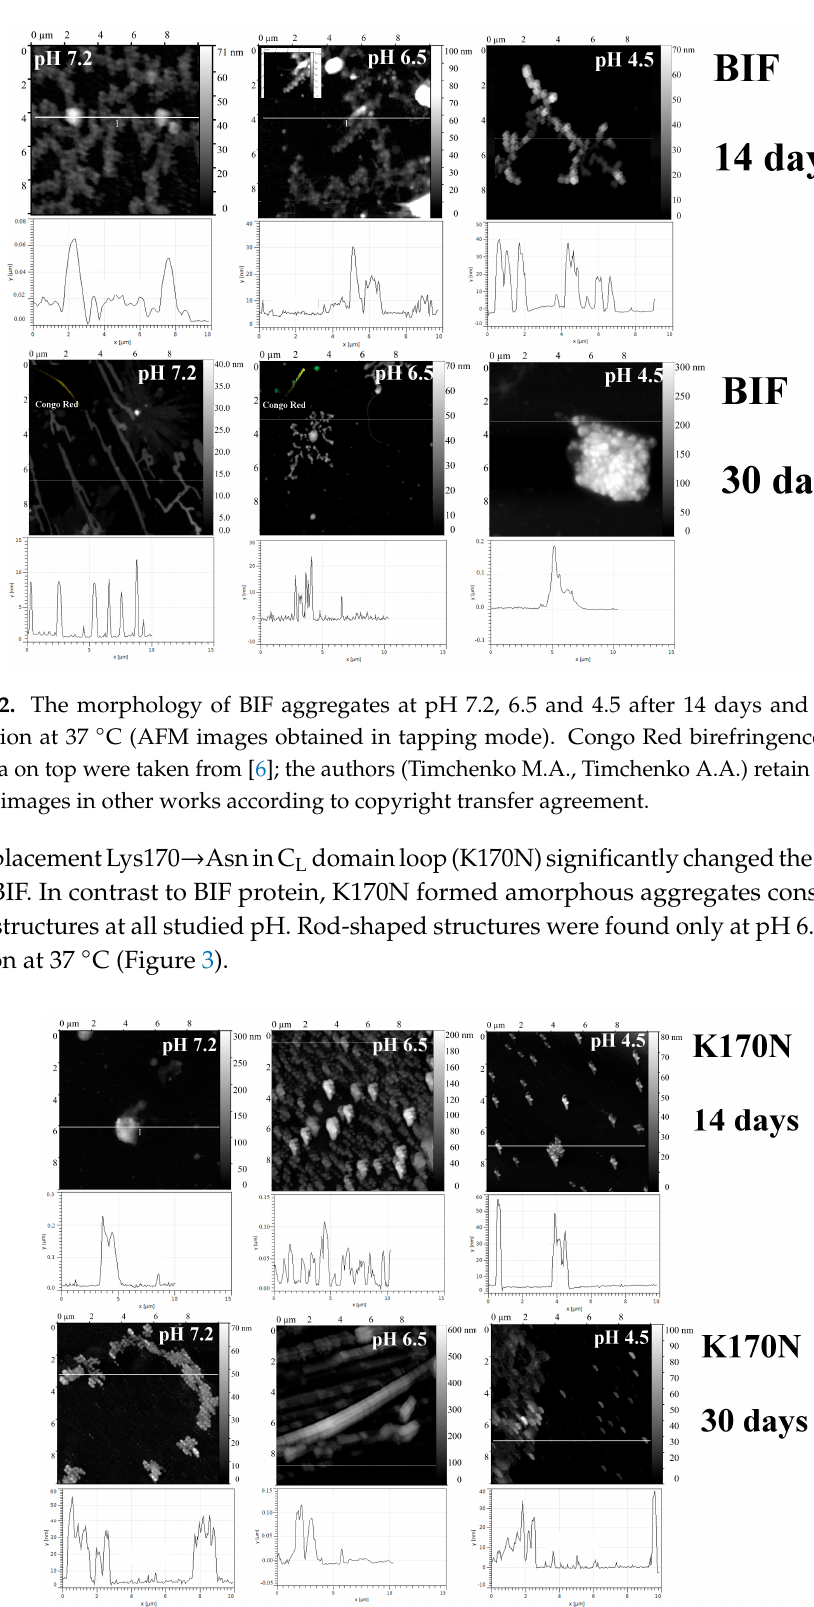
Figure 3. The morphology of K170N aggregates at pH 7.2, 6.5 and 4.5 after 14 days and 30 days of incubation at 37 °C (AFM images obtained in tapping mode).